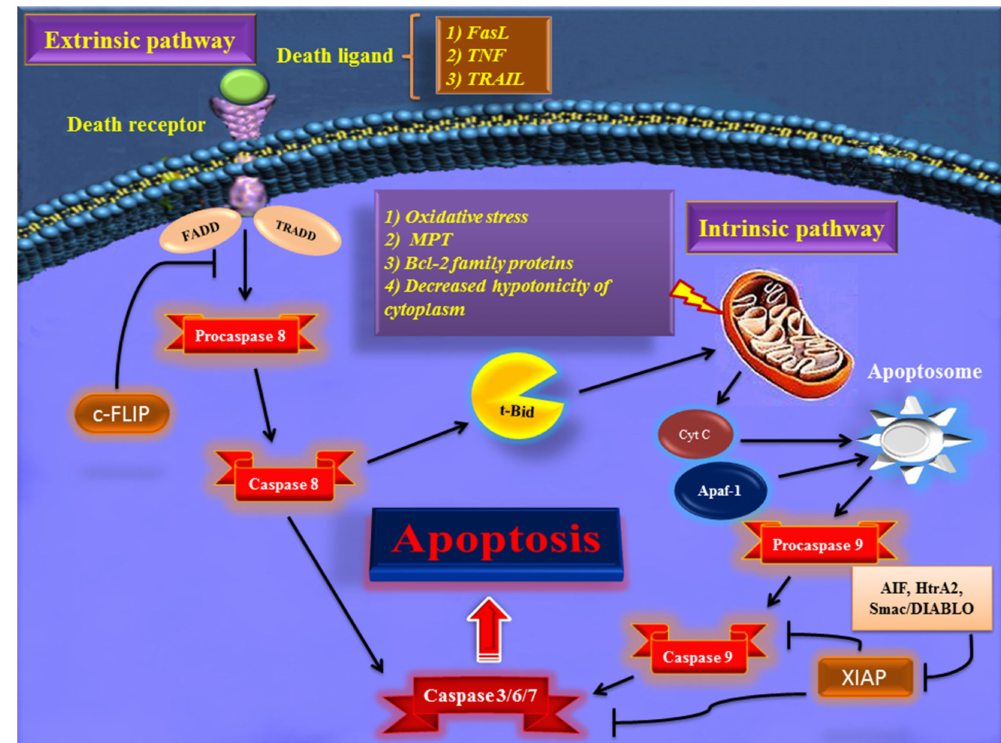
Figure 1. Overview of the extrinsic and intrinsic apoptosis signaling pathways and their major role-players. FasL—Fas ligand; TNF—tumor necrosis factor; TRAIL—TNF- related apoptosis-inducing ligand; TRADD—TNF receptor-associated death domain; FADD—Fas-associated death domain; Bcl-2—B cell lymphoma-2; Cyt c—cytochrome c; Apaf-1—apoptotic protease activating factor 1; AIF—apoptosis-inducing factor; Smac/DIABLO—second mitochondria-derived activator of caspase/direct IAP binding protein with low pI; HtrA2—Omi/high-temperature requirement protein A; XIAP—X- linked inhibitor of apoptosis protein; c-FLIP—cellular FADD-like IL-1 β -converting enzyme (FLICE) inhibitory protein; MPT—mitochondrial permeability transition; t -BID—truncated BH3 interacting-domain death